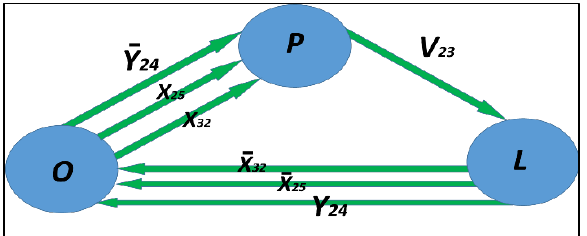
Figure 12. Automatic graph of the valve 23 in the mode of water chilling in the tank